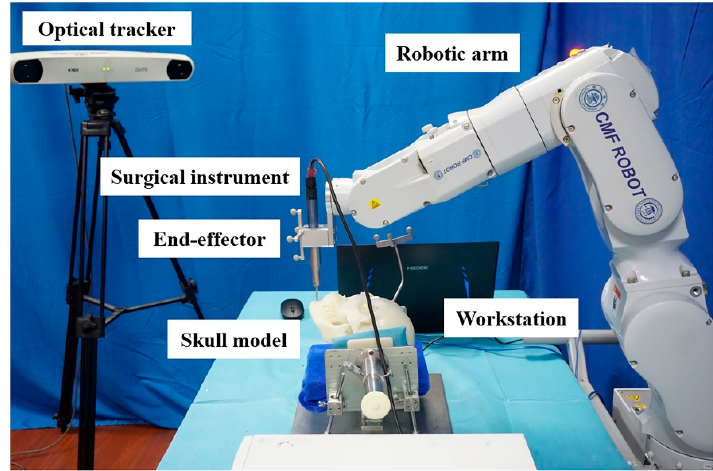
Figure 1. Structure of the CMF ROBOT